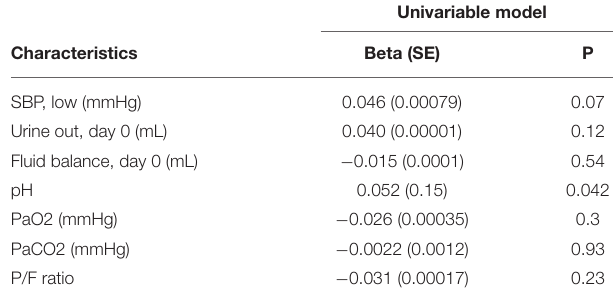
TABLE 2 | Univariable regression table for factors associated with PCSK9 level in ARDS.